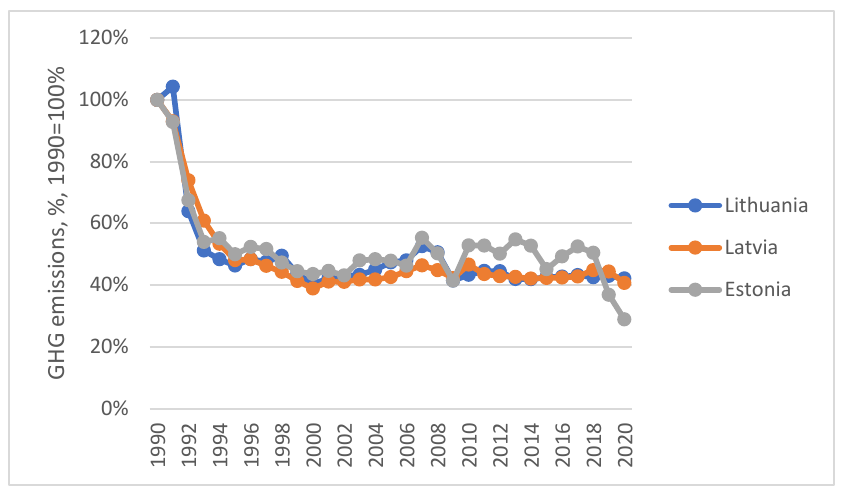
Figure 1. GHG emission reduction, %, 1990 = 100%. Source: Created by authors. Based on Refer- ence [44].